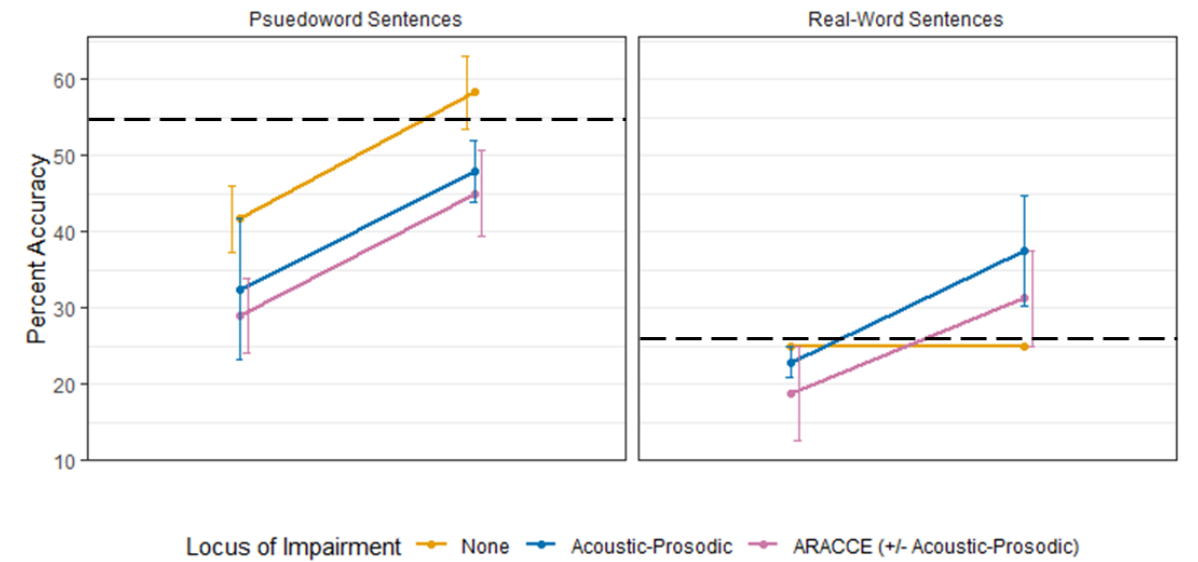
Figure 2. Mean and standard error of affective prosody recognition performance before and after training by behavioral impairment locus. Error bars are dodging so that full range can be appreciated for each group without interference of overlapping error bars. There were significant main effects of linguistic context (real-word < pseudoword sentences) and testing (pre-training < post-training) but no significant effect of behavioral impairment locus. The horizontal dashed black line represents the cutoff accuracy for impairment based on controls’ affective prosody recognition performance at pre-training.